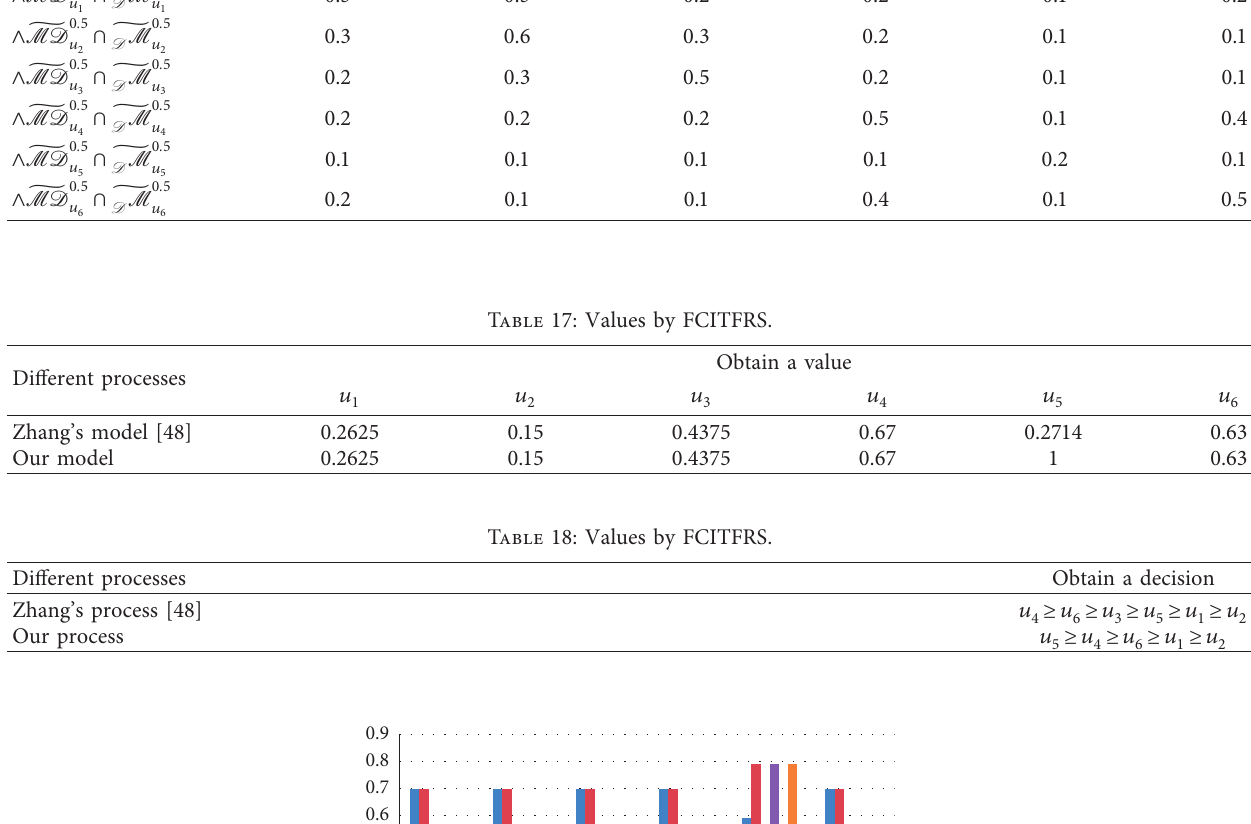
Table 16: The result for ∧ 􏽧 MD β